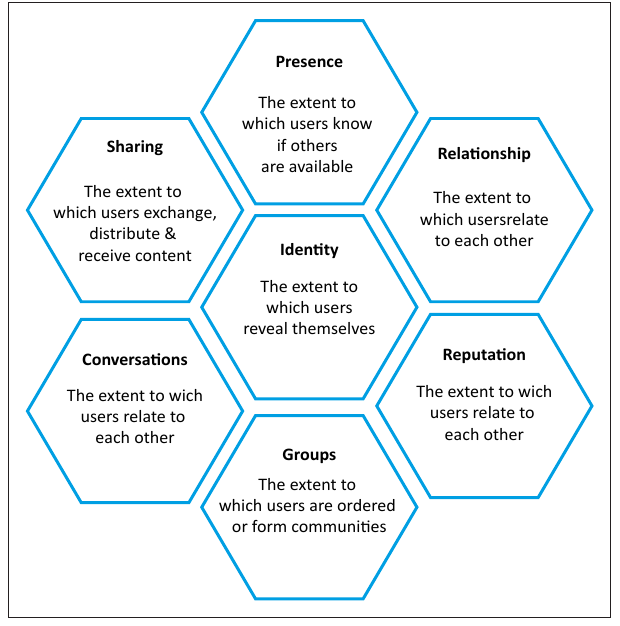
FIGURE 1: Social media functionality